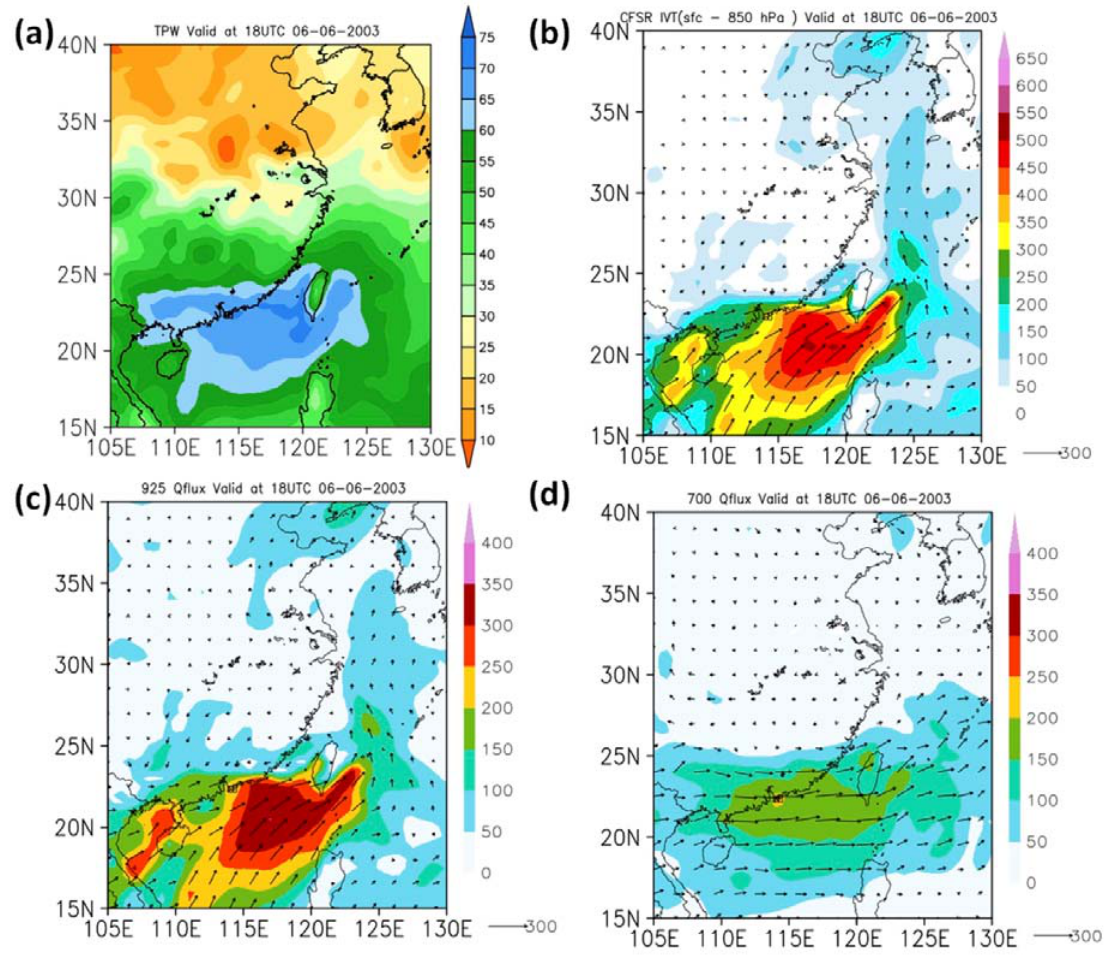
Figure 11. ( a ) The CFSR total precipitable water (TPW; kg m − 2 ); ( b ) the CFSR integrated vapor transport (IVT; kg m − 1 s − 1 ) in the boundary layer (sfc ‐ 850 hPa); ( c ) moisture flux (g kg − 1 m s − 1 ) at 925 hPa; and ( d ) same as ( c ) but for 700 hPa at 1800 UTC 6 June (0200 LT 7 June) 2003. The Hovmöller diagrams from 1200 UTC (2000 LT) 5 June to 0000 UTC (0800 LT)